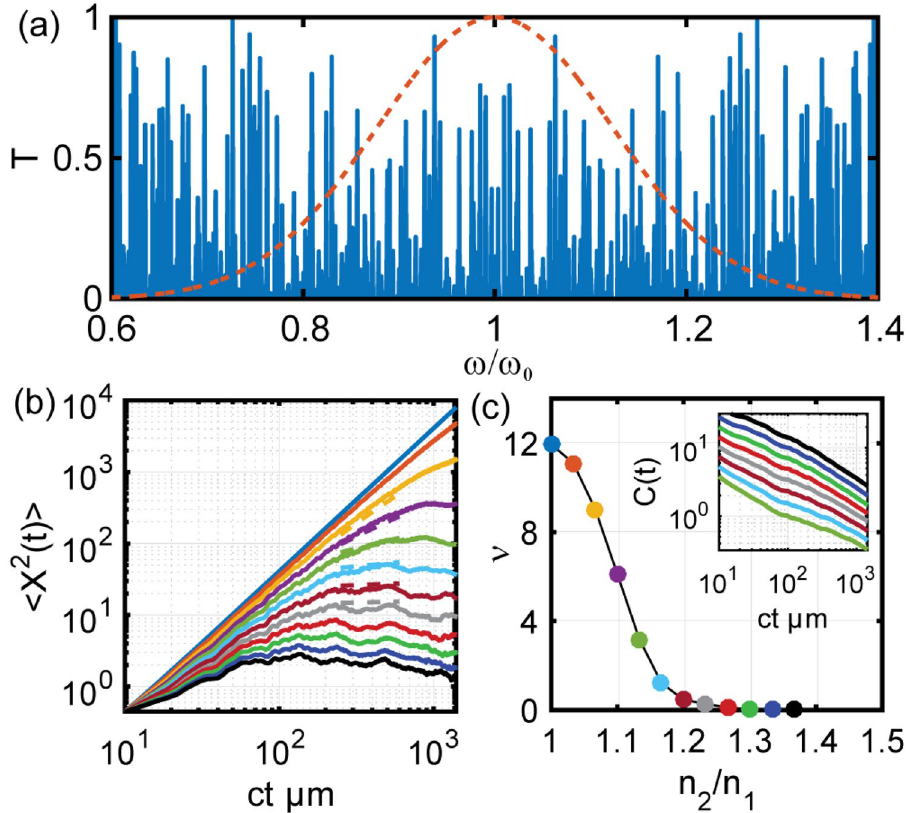
Figure 5. ( a ) Representative transmission spectrum of an RS multilayer with n 1 = 1.5 and n 2 = 1.75. The dashed line represents the frequency spectrum of the incident optical pulse at 1550 nm. ( b ) Calculated MSD scaling curves for different values of the refractive index contrast between the constituent layers. MSD scaling is observed to have logarithmic behavior in a double-log plot representing ultra-slow Sinai diffusion. The deviation from logarithmic behavior at higher time scales is due to the finite size of the system of layers (reflections from the other end of the layers). ( c ) Calculated scaling exponent of the MSD curves shown in panel ( b ) using the logarithmic Sinai model. The quality of the fitting is demonstrated with representative dashed lines overlapping the data in panel ( b ). Inset in ( c ) is calculated ACF for few representative refractive index contrasts. The lines are scaled vertically for better visualization. ‘ct’ in ( b ) and ( c ) is the time equivalent length where c represents the velocity of light in vacuum and t represents